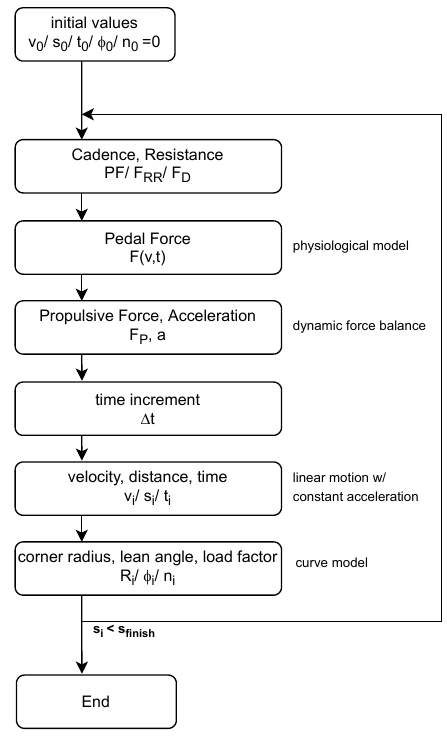
Figure 1. Computation